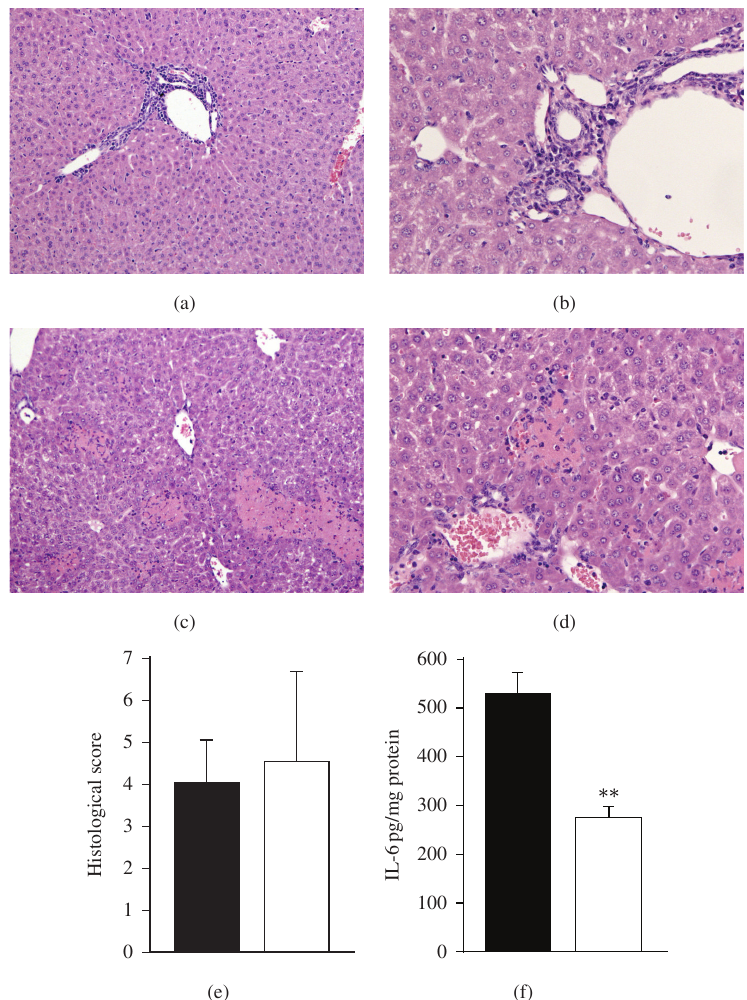
FIGURE 6: Histological hepatitis score and IL-6 protein expression in the liver of mice after ConA-induced hepatitis. Areas of portal inflammation (a and b) and necrosis (c and d) in ConA-induced hepatitis in control mice (histology of IL-37-expressing mice not shown). Histological hepatitis score analyzed for IL- 37 expressing mice (open bars) and control mice (closed bars) (e). IL-6 in liver lysate was analyzed by multiarray cytokine assay and is expressed as pg/mg total protein in liver lysate